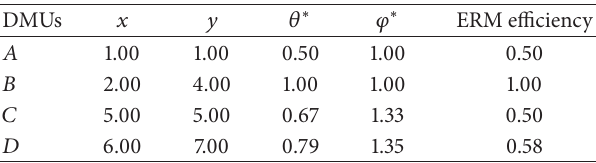
Table 2: The data in Example